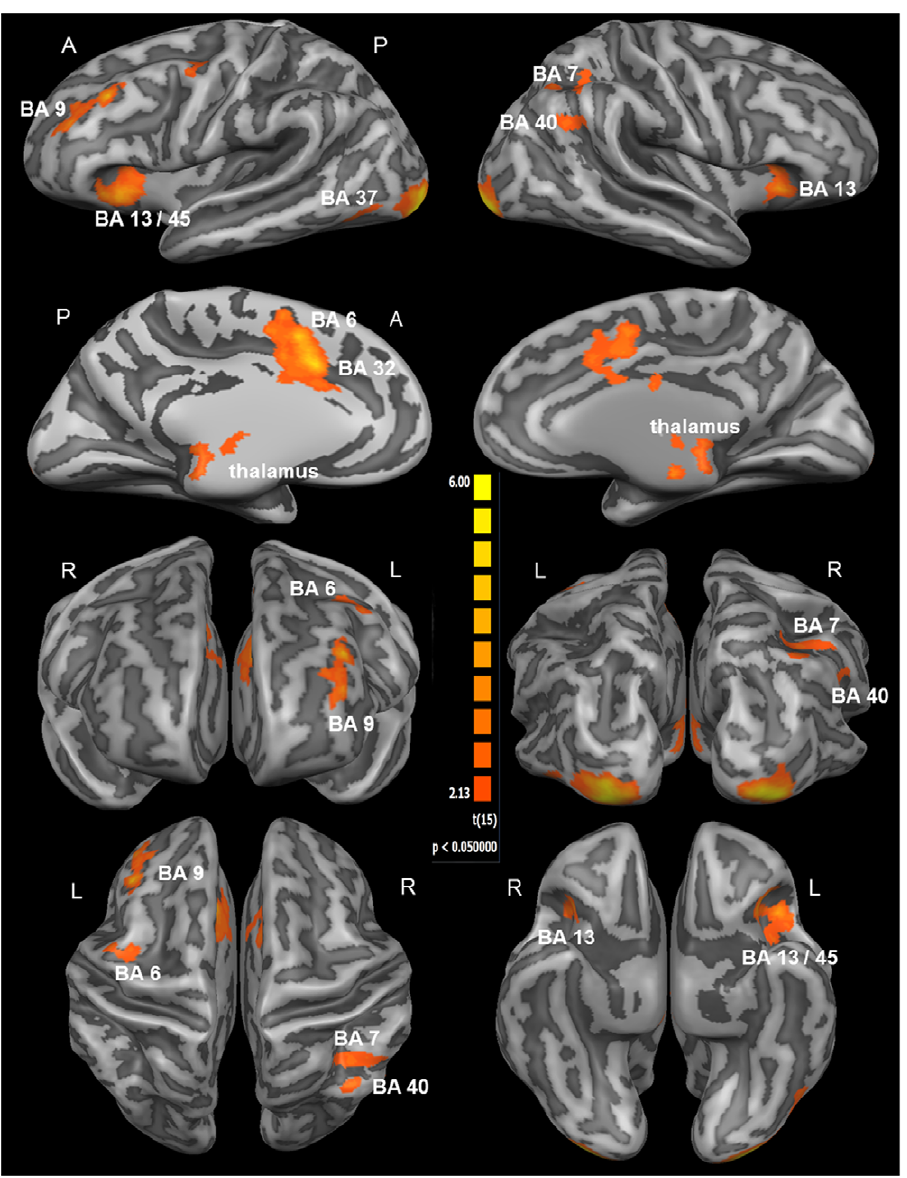
Figure 2. Whole-brain results of the first part of the fMRI analysis (RFX-GLM; n =16). The displayed clusters of activation result from the contrast Intrinsic Alertness Task . Control Task, showing all cortical activations related to the processing of intrinsic alertness. For visualization, results were projected onto the optimized 3D surface reconstruction which represents the average brain of all participants. At the individual voxel-level, activations were thresholded at p =0.05 (uncorrected). Subsequently, a cluster-size threshold of k=34 voxels was applied, which together resulted in a cluster-level false-positive rate of 5% (whole-brain corrected p =0.05). The first two rows show lateral and medial views of the brain, the third row shows the front and back view of the brain, and the fourth row depicts top and bottom view of the brain. For a complete list of functional activations resulting from the contrast Intrinsic Alertness Task . Control Task, see Table 1. (A=anterior; BA=Brodmann area; P=posterior; R=right hemisphere; L=left hemisphere)